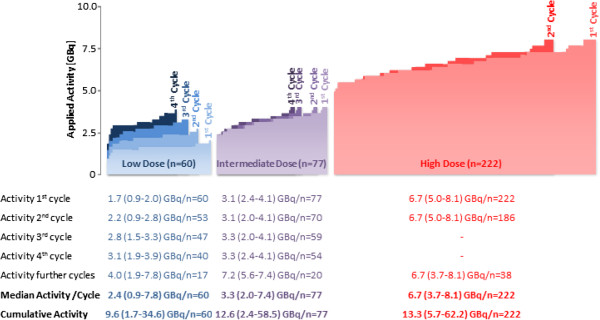
Dosage protocol.